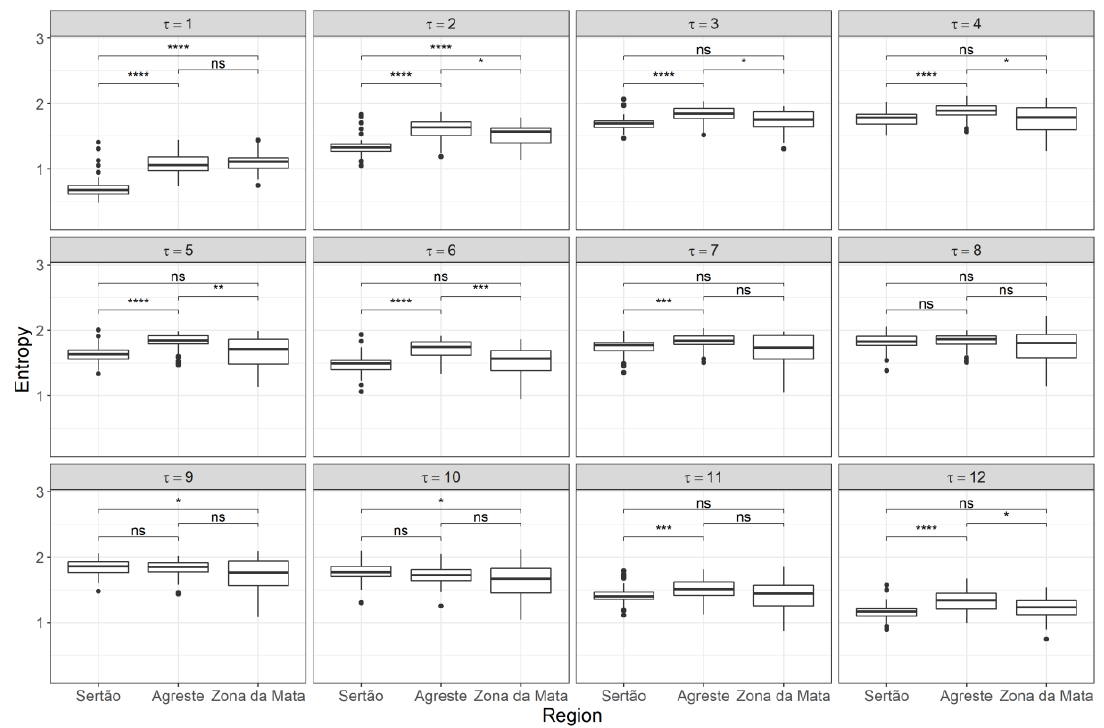
Figure 8. Boxplots for MMSE values (original series) for the regions of Zona de Mata, Agreste, and Sertão for τ = 1, 2, …, 12. “*”, “**”, “***”, “****” indicate that there is a significant difference between the regions at the 5%, 1%, 0.1%, 0.01% significance level, respectively; “ns” means not significant.